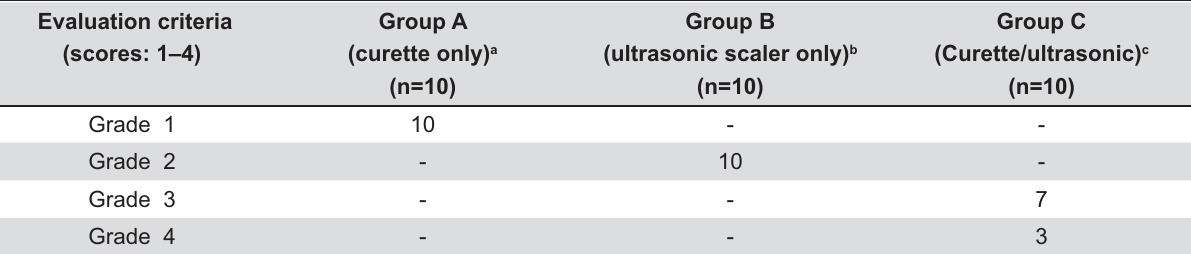
QW(cid:12)(cid:3)(cid:3)(cid:8)(cid:9)(cid:8)(cid:24)(cid:30)(cid:4)(cid:14)(cid:2)(cid:15)(cid:8)(cid:9)(cid:4)(cid:11)(cid:13)(cid:5)(cid:8)(cid:4)(cid:14)(cid:8)(cid:30)(cid:30)(cid:8)(cid:9)(cid:5)(cid:4)(cid:12)(cid:24)(cid:25)(cid:12)(cid:11)(cid:13)(cid:30)(cid:8)(cid:4)(cid:5)(cid:30)(cid:13)(cid:30)(cid:12)(cid:5)(cid:30)(cid:12)(cid:11)(cid:13)(cid:14)(cid:14)$(cid:4)(cid:5)(cid:12)!(cid:24)(cid:12)(cid:10)(cid:11)(cid:13)(cid:24)(cid:30)(cid:4)(cid:25)(cid:12)(cid:3)(cid:3)(cid:8)(cid:9)(cid:8)(cid:24)(cid:11)(cid:8)(cid:5)(cid:4)(cid:18)XY(cid:22)/(cid:22)(cid:22)Z(cid:23)/(cid:4)[(cid:31)(cid:8)(cid:4)(cid:5)(cid:7)(cid:8)(cid:11)(cid:12)"(cid:8)(cid:24)(cid:5)(cid:4)(cid:15)(cid:8)(cid:9)(cid:8)(cid:4)(cid:13)(cid:5)(cid:5)(cid:8)(cid:5)(cid:5)(cid:8)(cid:25)(cid:4)(cid:6)(cid:5)(cid:12)(cid:24)!(cid:4) the following index of smear layer removal: (Grade 1: thick and compact smear layer, no dentinal tubules open; Grade 2: thin smear layer, no presence of dentinal tubules; Grade 3: Residues of smear debris partially occluding dentinal tubules;